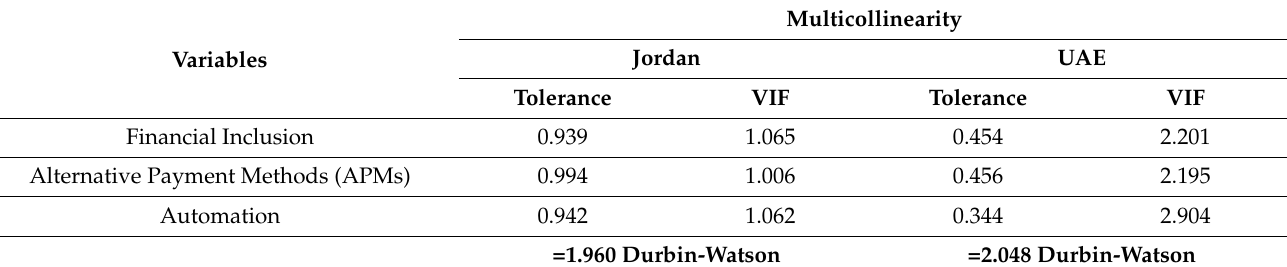
Table 8. Validity of Study Data for Statistical